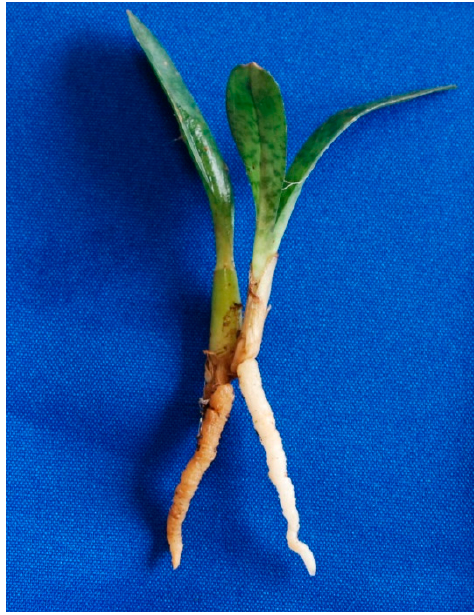
Figure 1. A plant of Oeceoclades maculata showing an older and darker mycorrhizal root on the left and a younger and paler non-mycorrhizal root on the right. Roots belonging to the two types were checked for their mycorrhizal status by microscopic screening before being subject to molecular analyses.